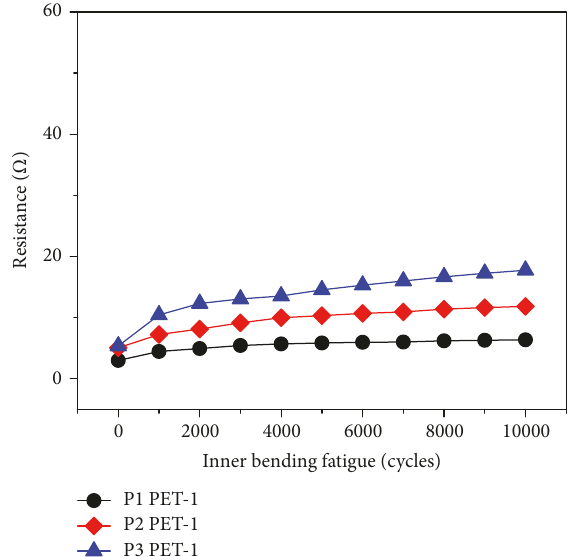
Figure 12: Electrical resistance versus bending cycle plot for inner bending fatigue